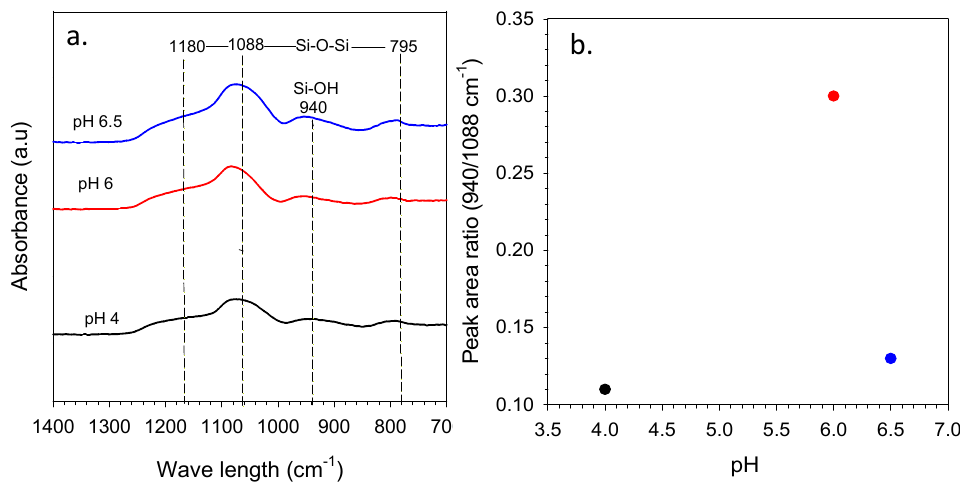
Figure 6. ( a ) FTIR spectra of organo-silica xerogels at varied pH and ( b ) the peak area ratio of silanol/siloxane for the function of sol pH.